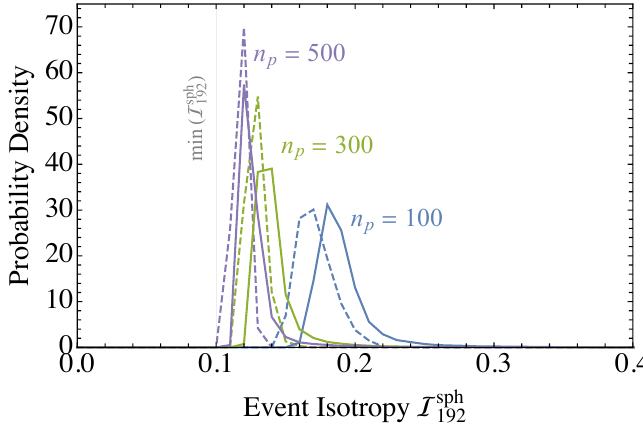
distributions for n = 100 , 300, and 500 of the spherical toy p 192 increases, the ν = 0 sample approaches p